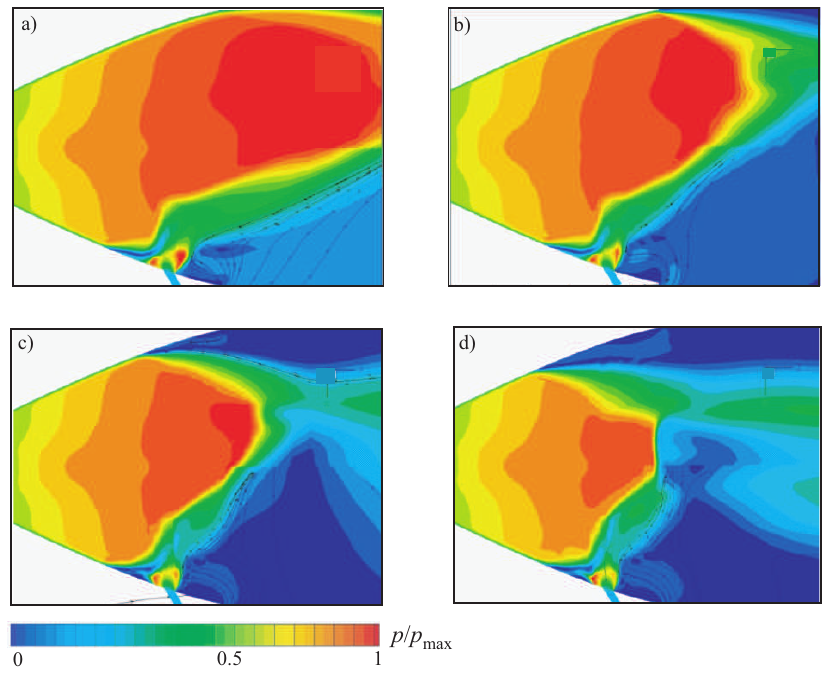
Figure 14. Contours of static pressure for: n = 0.4, p n = 0.5 atm ( a ); n = 0.2, p n = 1.0 atm ( b ); n = 0.2, p n = 1.5 atm ( c ); n = 0.1, p n = 2.0 atm ( d